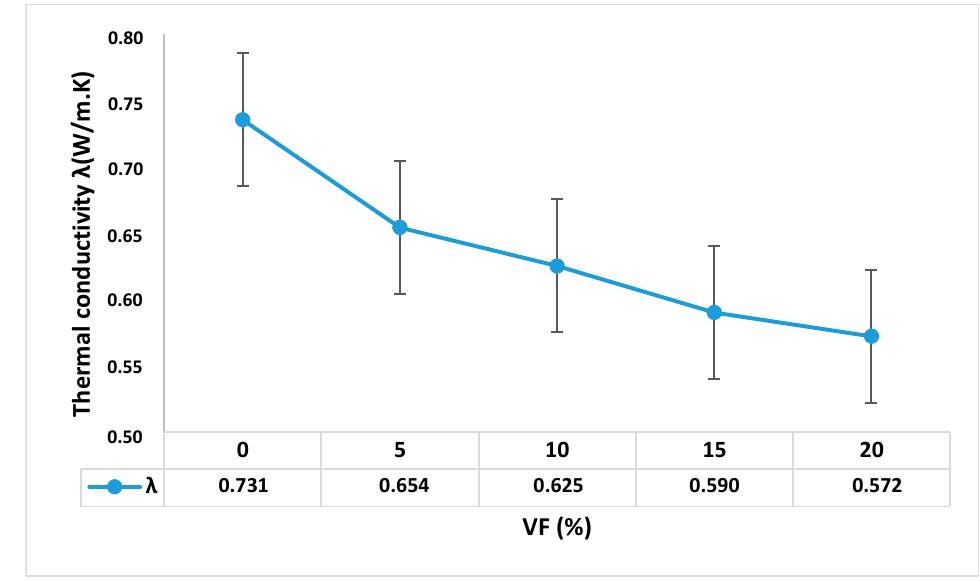
Figure 9. Effect of PO fibers on the thermal conductivity of the mixtures.